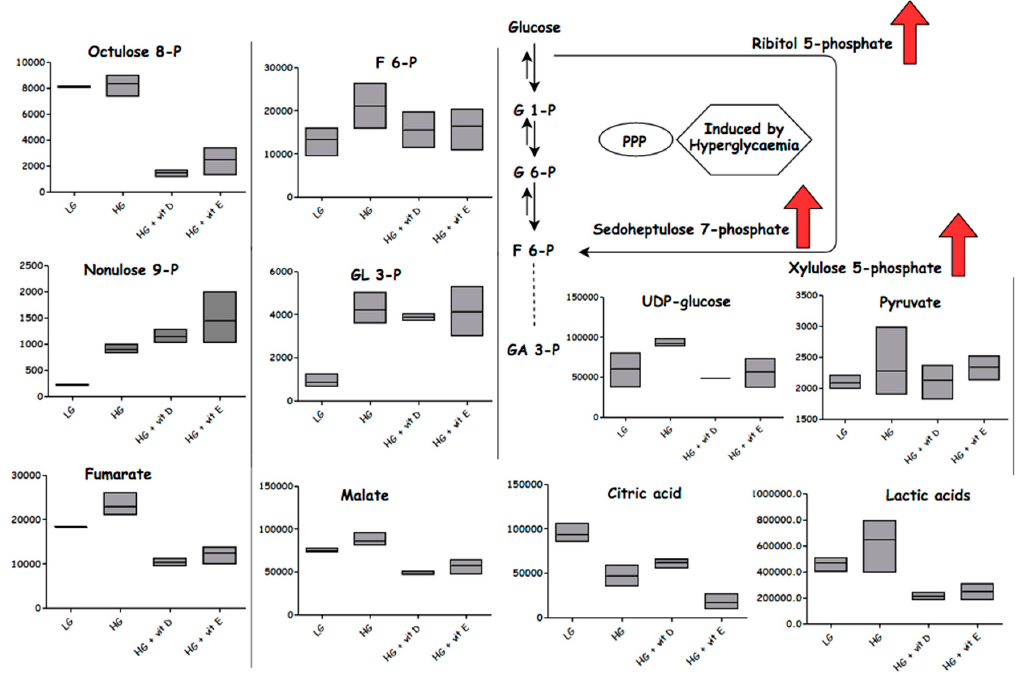
Figure 10. Metabolites affected by different conditions: normoglycemia (LG), hyperglycemia (HG), with vitamin D or vitamin E. Column figures display the average intensities of specific metabolites in different conditions. G1-P: glucose 6-phosphate; G6-P: glucose 6-phosphate; GA 3-P: 3-phosphoglyceraldehyde; F6-P: fructose 6-phosphate.